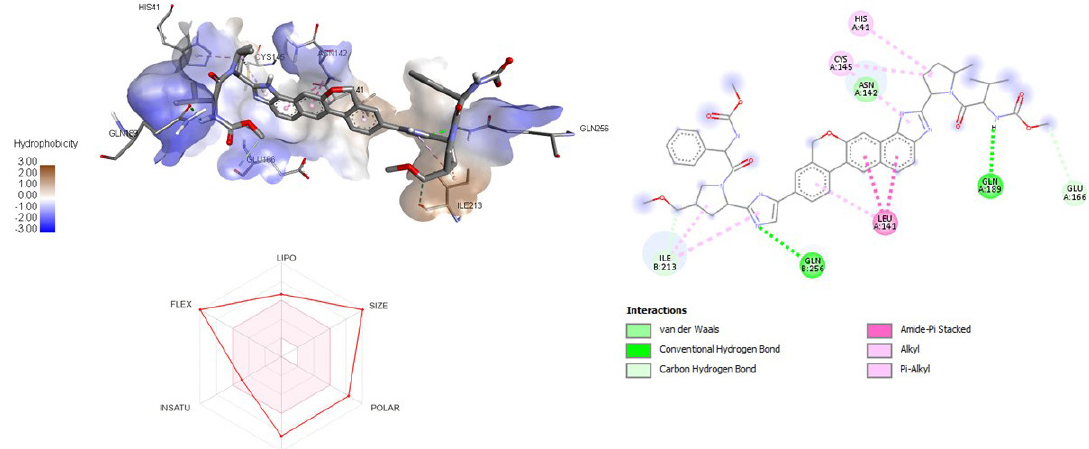
Figure 7. 3D and 2D interaction of ligand velpatasvir with SARS-CoV-2 protein (PDB ID: 7P35) along with in silico ADMET